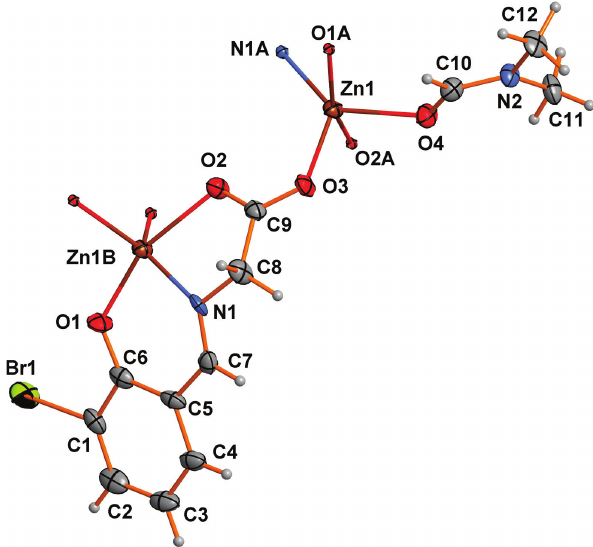
Table 1: Data collection and